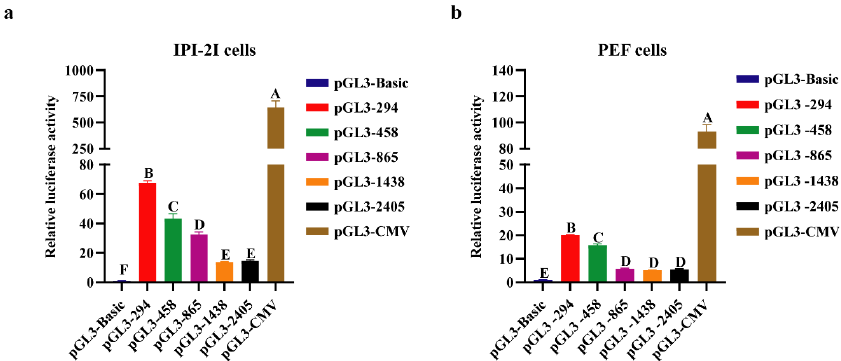
Figure 4. Transcriptional activity of porcine COL1A1 promoter. Luciferase reporter plasmids con- taining different lengths of porcine COL1A1 promoter (294–2405 bp) or control vectors (pGL3-Basic and pGL3-CMV) were transiently transfected into IPI-2I and PEF cells, respectively. Transfection efficiency was normalized by co-transfection with Renilla luciferase vector. For each vector in each experiment, three transfections were carried out. The relative luciferase activity is presented as the SEM. Differences between multiple groups were accessed by ANOVA with SPSS 20.0. Groups with different capital letters (A-F) are significantly different ( p < 0.05). ( a ) Activity analysis of the porcine COL1A1 promoter of different lengths in IPI-2I cells; ( b ) Activity analysis of the porcine COL1A1 promoter of different lengths in PEF cells.